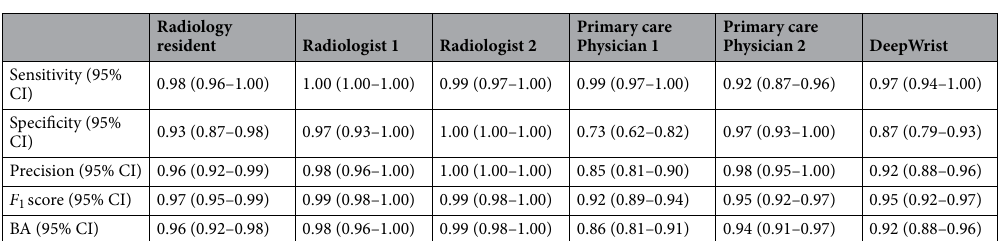
Table 3. Performance of 5 readers and DeepWrist on trivial cases (test set #1). 95% confidence intervals (CI) are shown in parentheses. BA stands for balanced accuracy.